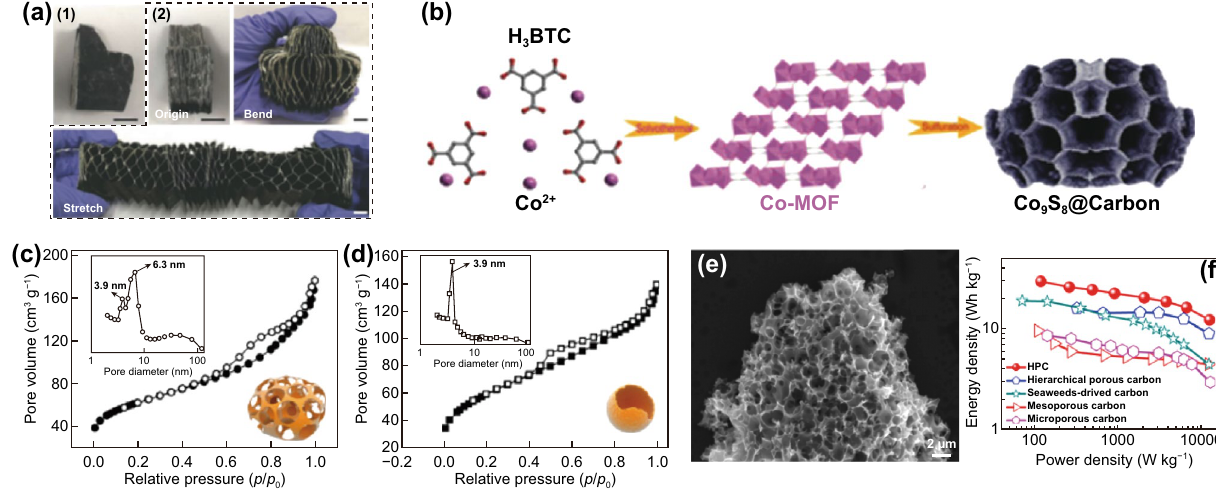
Fig. 2 a 3D stretchable supercapacitors with various shape. Reproduced with permission from Ref. [100]. Copyright 2018, Wiley–VCH; b Schematic illustration of Co 9 S 8 @C ‐ 500 synthesis strategy. Reproduced with permission from Ref. [101]. Copyright 2018, Wiley–VCH; N 2 adsorption (close symbol)–desorption (open symbol) isotherms of RuO 2 ·xH 2 O 3D architectures c RHCs and d RHSs; inset shows the corre- sponding BJH pore size distribution curves obtained from the desorption branch. Reproduced with permission from Ref. [102]. Copyright 2017, ACS Publications; e SEM image of HPC, f Ragone plots of the HPC symmetrical supercapacitor Reproduced with permission from Ref.